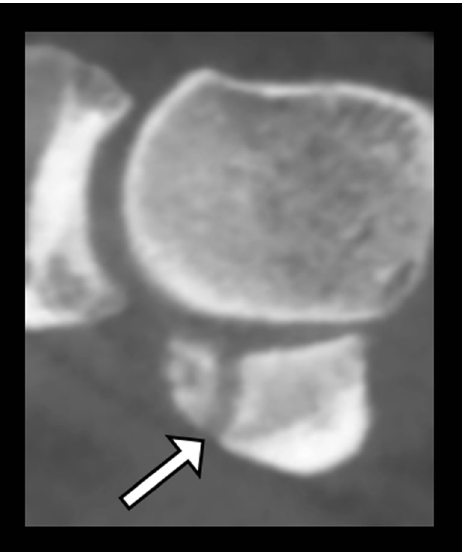
Fig. 14 Bifid medial sesamoid bone of the hallux. Sagittal reformatted CBCT demonstrating the presence of this anatomical variant